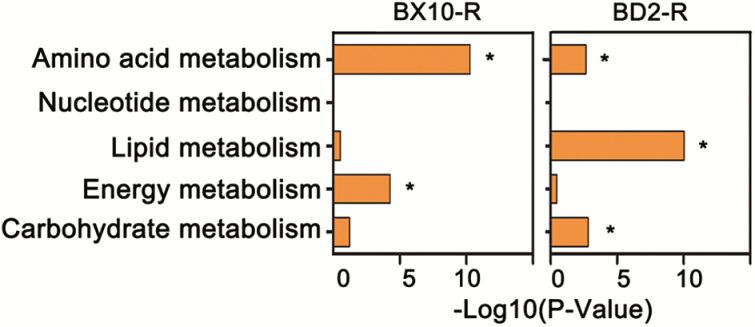
KEGG enriched pathways of DEGs in the roots of BX10 and BD2. Asterisk (*) indicates significant difference at P < 0.05.